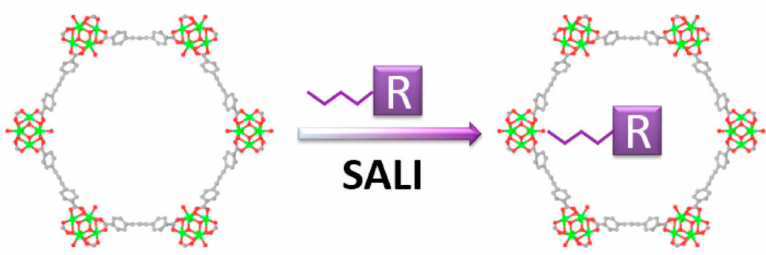
Figure 13. Solvent-assisted ligand incorporation onto Zr-nodes of NU-1000. Perfluoro alkane carboxylates were successfully incorporated on the Zr6 nodes of NU-1000 [114].